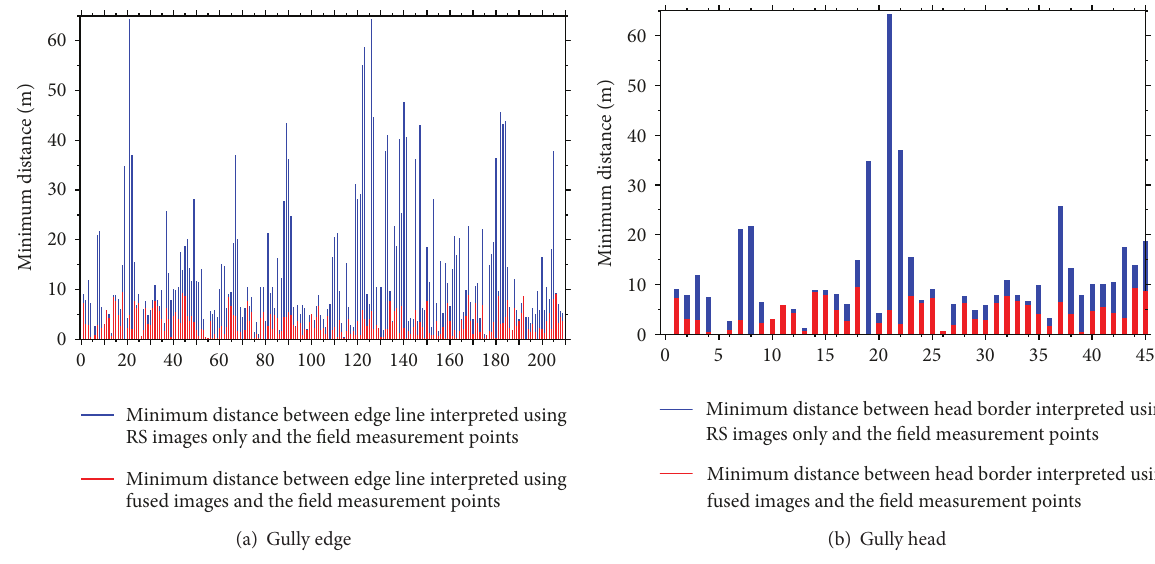
Figure 5: Minimum distance between points field measured and gully interpreted using RS images only and fused